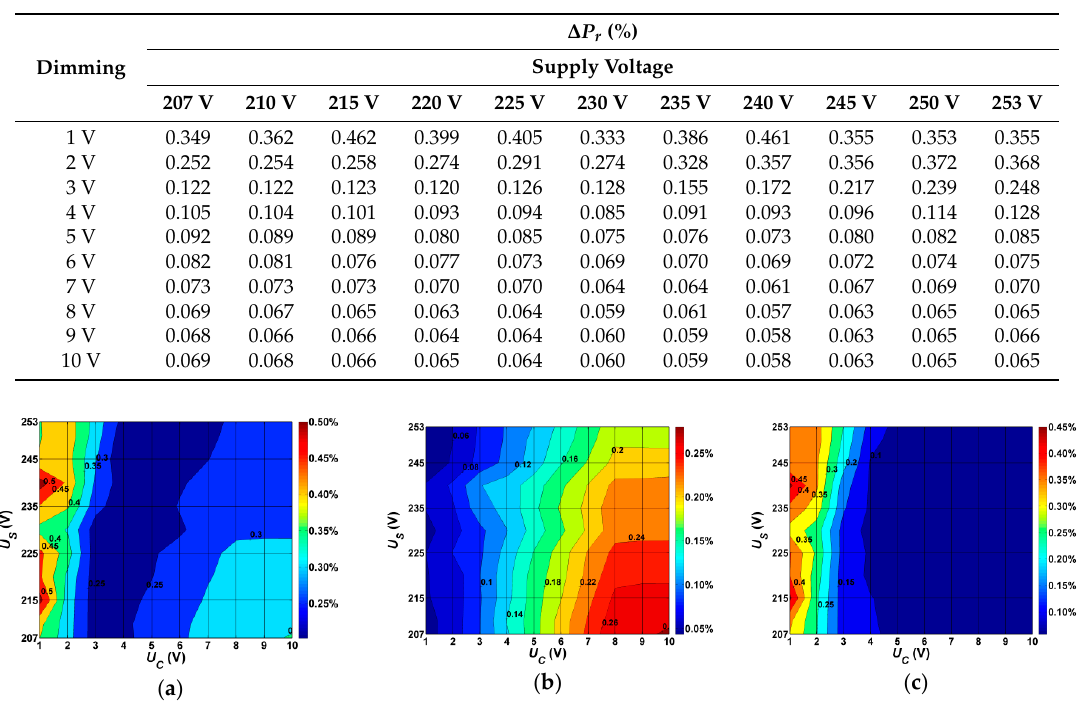
Figure 2. Active power losses in a street lighting circuit with 30 luminaires as percentages of the circuit power P kc : ( a ) total power losses Δ P TOTAL ; ( b ) active power losses caused by flow of active power Δ P a , ( c ) active power losses caused by flow of reactive power Δ P r .